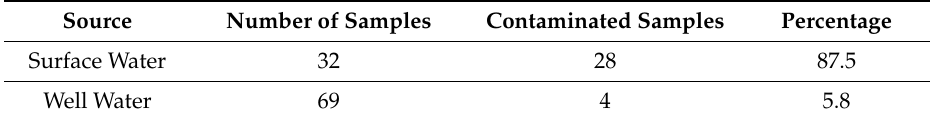
Table 1. Percentage of positive samples of generic Escherichia coli obtained from sixty Iowa fresh produce farm